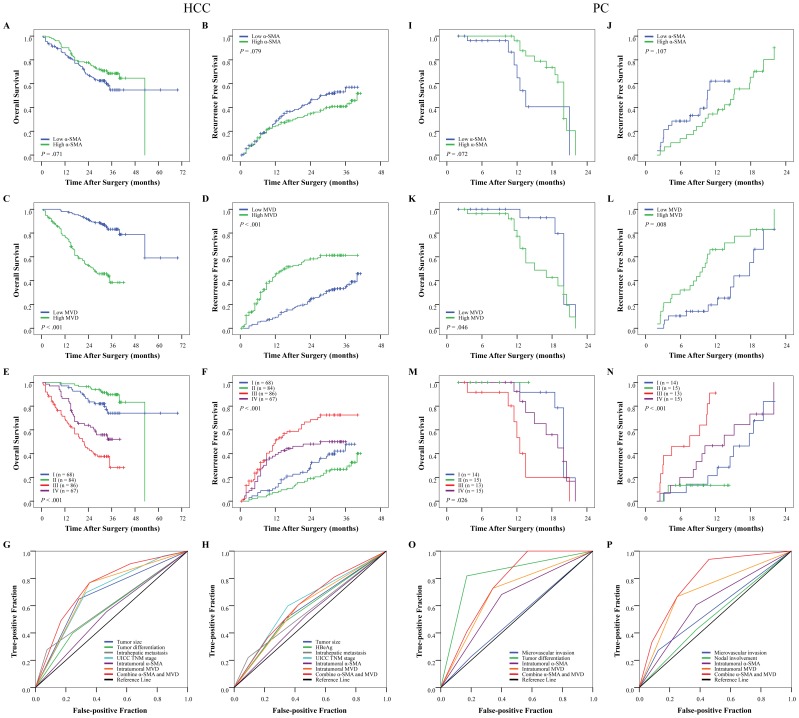
Cumulative overall survival (OS) and recurrence-free survival (RFS) curves of patients with low or high tumor alpha-smooth muscle actin (α-SMA) density, microvessel density (MVD), and their combination.(A, B, I, J) The α-SMA density was associated with neither OS nor RFS. (C, D, K, L) Low MVD was correlated with prolonged OS and RFS. (E, F, M, N) Patients in each cohort were classified into four groups according to their intratumoral α-SMA density and MVD. (G, H, O, P) The predictive values of marker combination and other risk factors identified by multivariate analysis were studied by receiver operating characteristic analysis (see Results for details). UICC, International Union against Cancer.